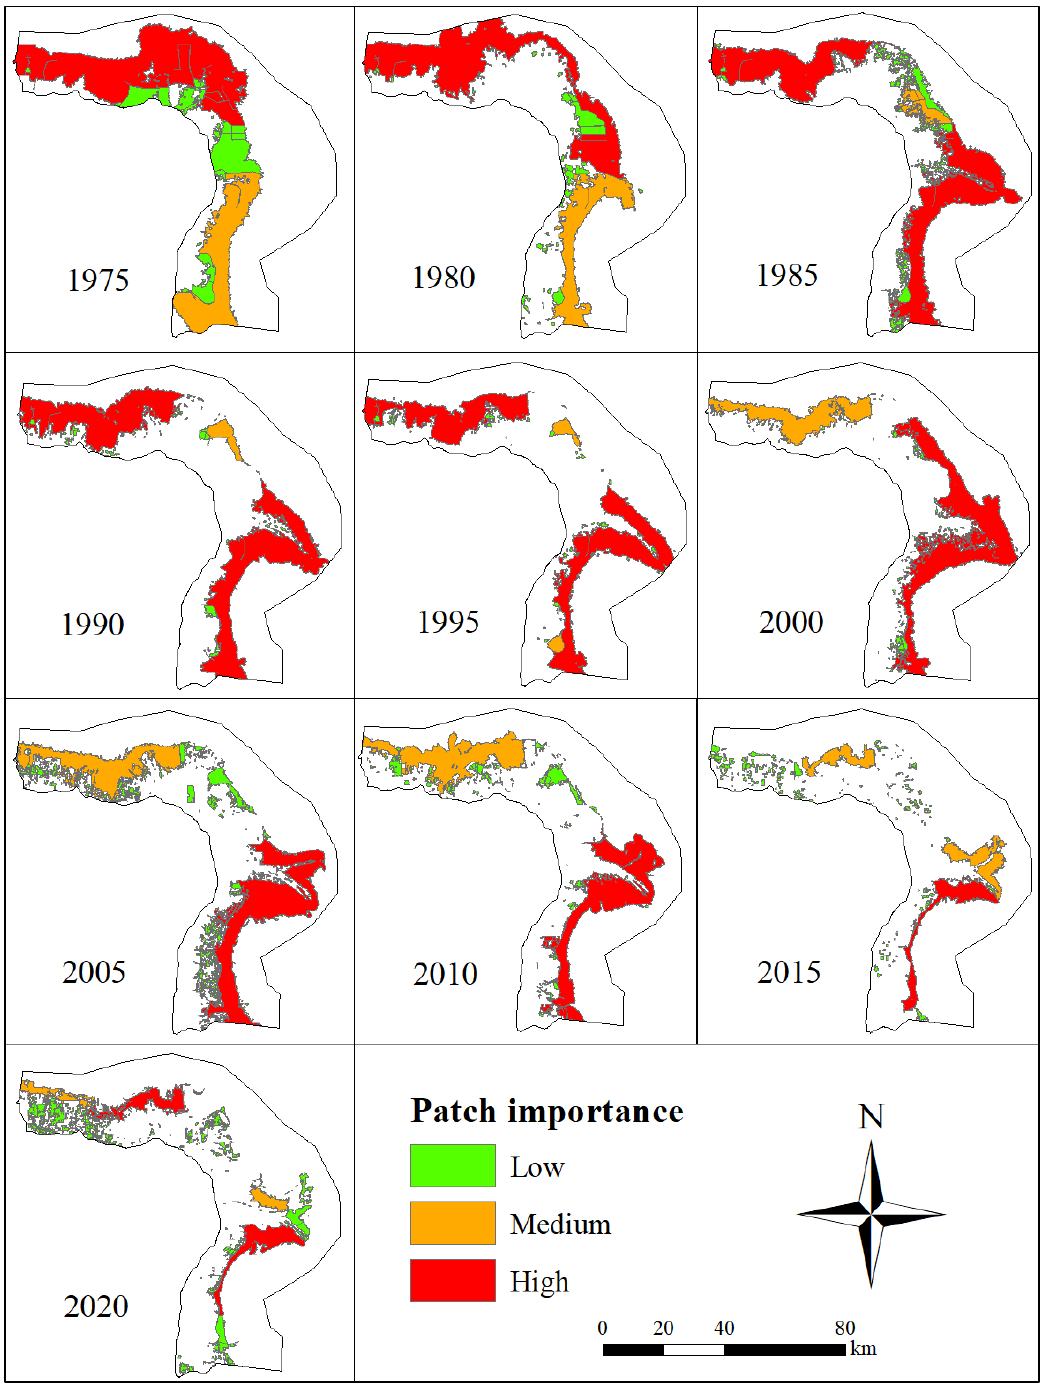
Figure 5. Habitat patch importance for maintaining habitat connectivity between 1975 and 2020. From 1975 to 2020, 71.0%, 11.6%, and 5.8% of the habitat area with HPI were converted to NH, habitat with LPI, and habitat with MPI, respectively. The area converted was mainly distributed in the northwestern part of the Yellow River Delta. A large intact patch with HPI was segmented into a single patch with MPI and 306 patches with LPI (Figure 6). A total of 58.9%, 11.7%, and 29.4% of the area with MPI was converted to non-habitat patches, habitat with LPI, and habitat with HPI, respectively. A large intact patch with MPI was segmented into 168 patches with LPI and one patch with HPI (Figure 6). The area converted was mainly distributed in the eastern part of the Yellow River Delta.